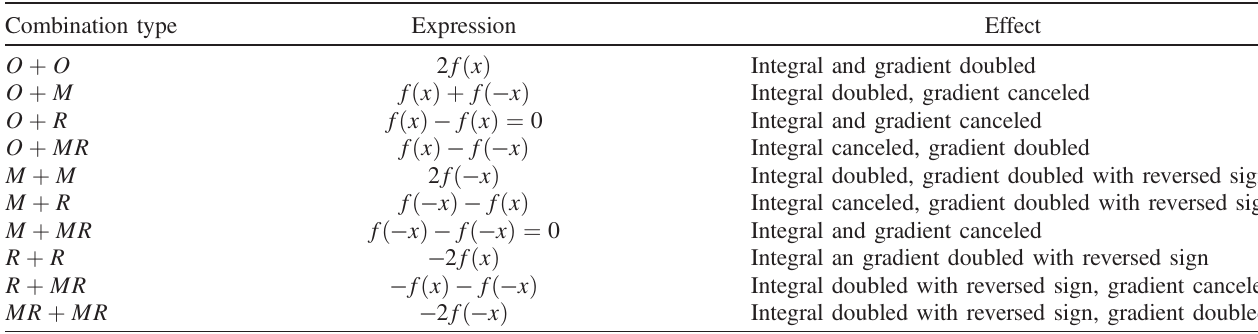
TABLE II. Combination of shims and resulting